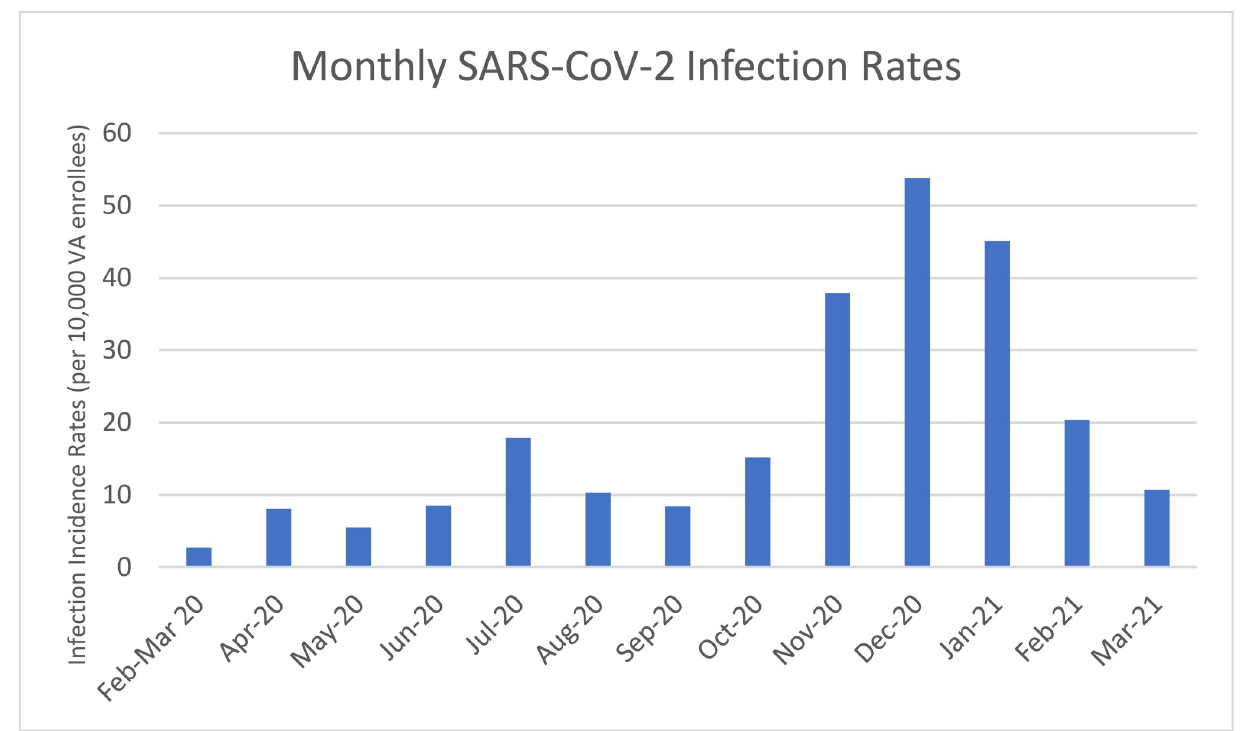
Fig 1. Monthly results in the VA healthcare system from February 2020 to March 2021 of SARS-CoV-2 infection rates among a cohort of VA enrollees. S AU : AbbreviationlistshavebeencompiledforthoseusedthroughoutFigs 1 (cid:0) 4 : Pleaseverifythatallentriesarecorrect : ARS-CoV-2, Severe Acute Respiratory Syndrome Coronavirus 2; VA, Veterans Affairs.